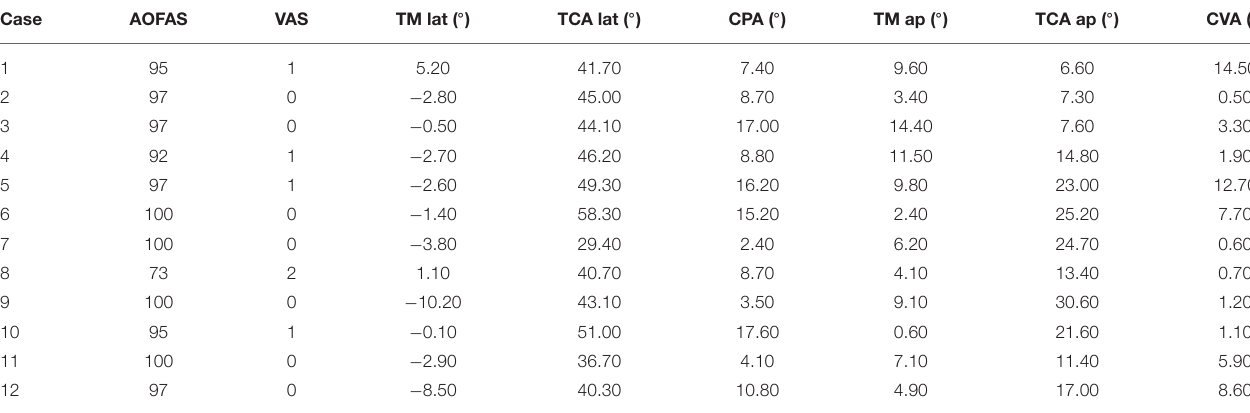
TABLE 3 | Postoperative clinical and radiographic results.